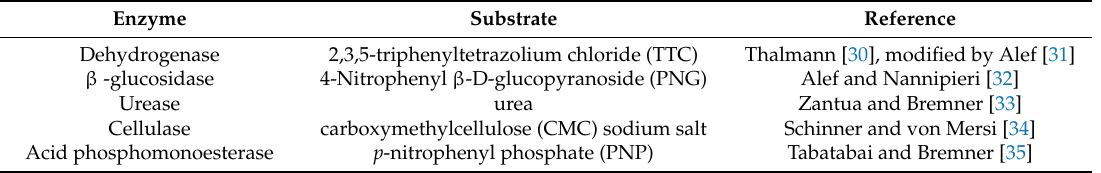
Table 2. Methods used for the assessment of enzyme